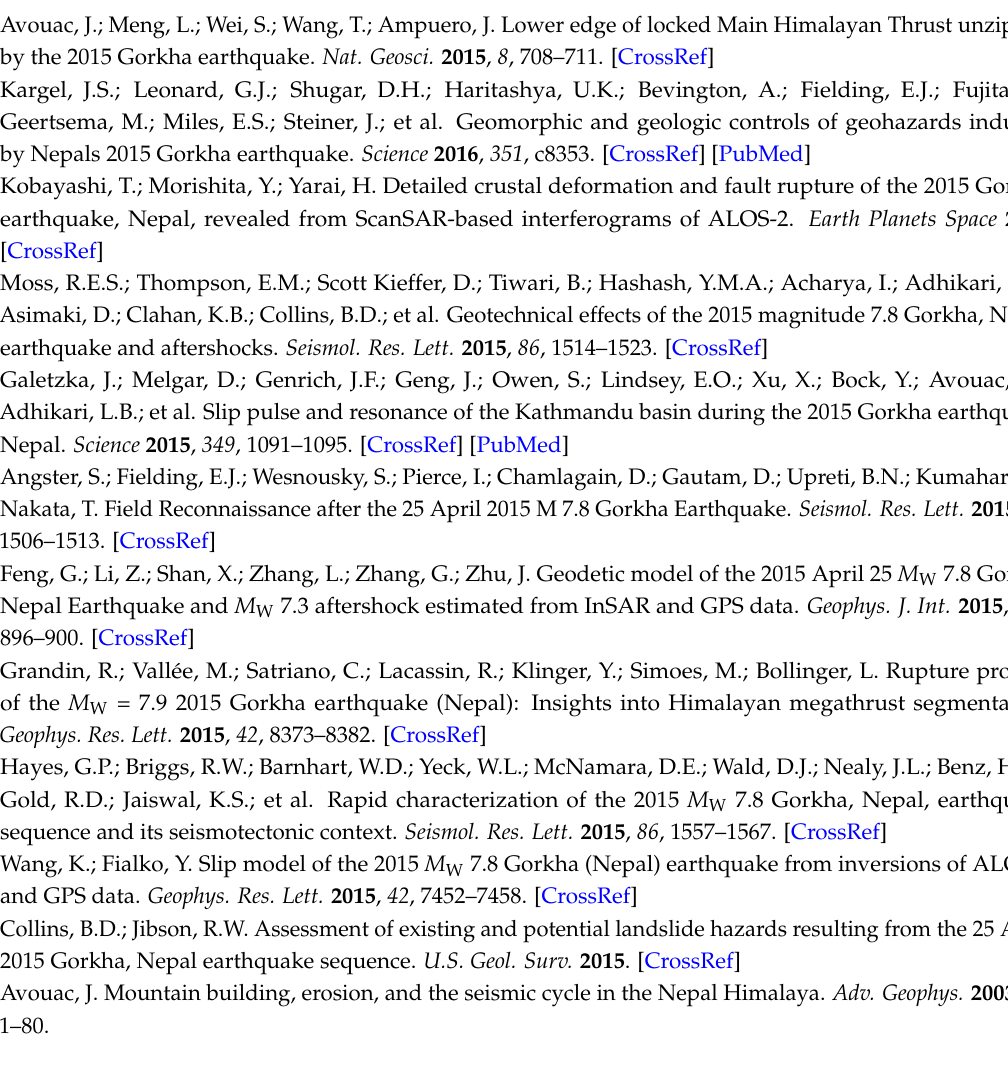
Table S1: Fault geometry in the synthetic tests, Table S2: Interferograms associated with the Gorkha earthquake used in this Study, Figure S1: Fault slip distribution and InSAR LOS measurements used in the synthetic tests, Figure S2: Unit vectors relating InSAR LOS measurements to surface displacements used in synthetic tests, Figure S3: Unit vectors relating InSAR LOS measurements to surface displacements for the ALOS images used in the Gorkha earthquake, Figure S4: Comparisons of observed and modeled InSAR LOS displacements for the Gorkha earthquake, Figure S5: Three-dimensional surface displacement field due to the Gorkha earthquake modeled with SISTEM approach, Figure S6: Differences between derived displacements with RSISTEM and SISTEM approaches, Figure S7: Comparison of solutions with different input, Figure S8: Model resolution test for Gorkha earthquake given data